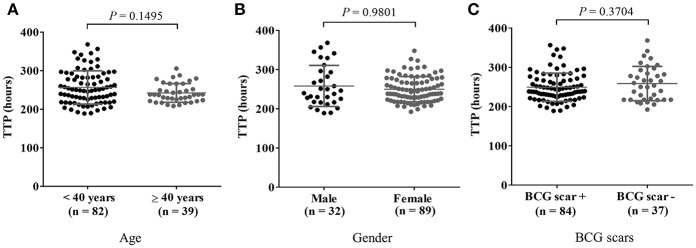
MGIA results in comparison with general characteristics of participants. Cryopreserved PBMC prepared from blood samples from 121 healthy adults were thawed and incubated with BCG for 4 days after which remaining mycobacteria were quantified using BACTEC MGIT tubes. In vitro mycobacterial growth in the PBMC based-MGIA assay is presented in panel (A) by age group, in (B) by gender, and in (C) by presence of a BCG scar(s) in healthy adults. A Mann-Whitney U-test was used for comparison of the two groups. P-value ≤ 0.05 was taken as statistically significant. The growth of BCG Pasteur was plotted as TTP (Time to Positive) in hours.